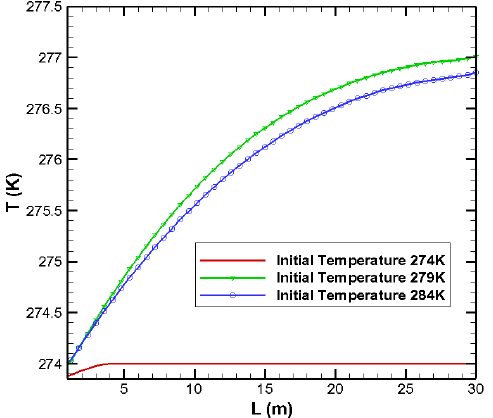
Figure 4. Comparison of pressure distribution in the reservoir under well pressure of 5 MPa and initial temperature of 284 K at different exploiting times (300 min, 3000 min, and 30,000 min). Figure 5. Comparison of temperature distributions in reservoirs under well pressure of 3 MPa, and different initial temperatures (274 K, 279 K, and 284 K) at exploiting time of 300 min.